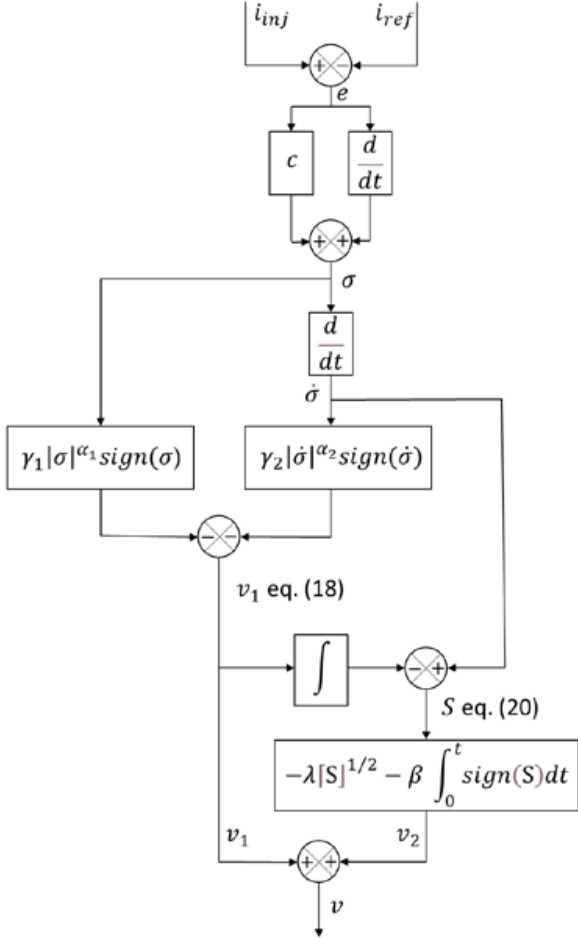
Figure 4. Flowchart of the C-HOSM controller.